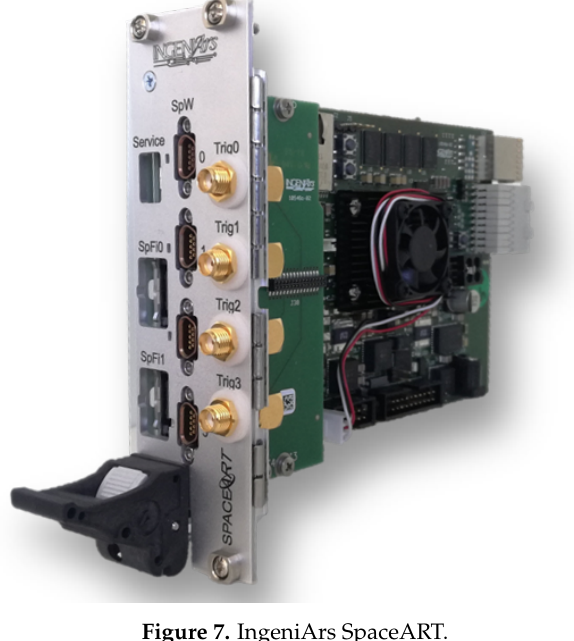
Figure 7. IngeniArs SpaceART.